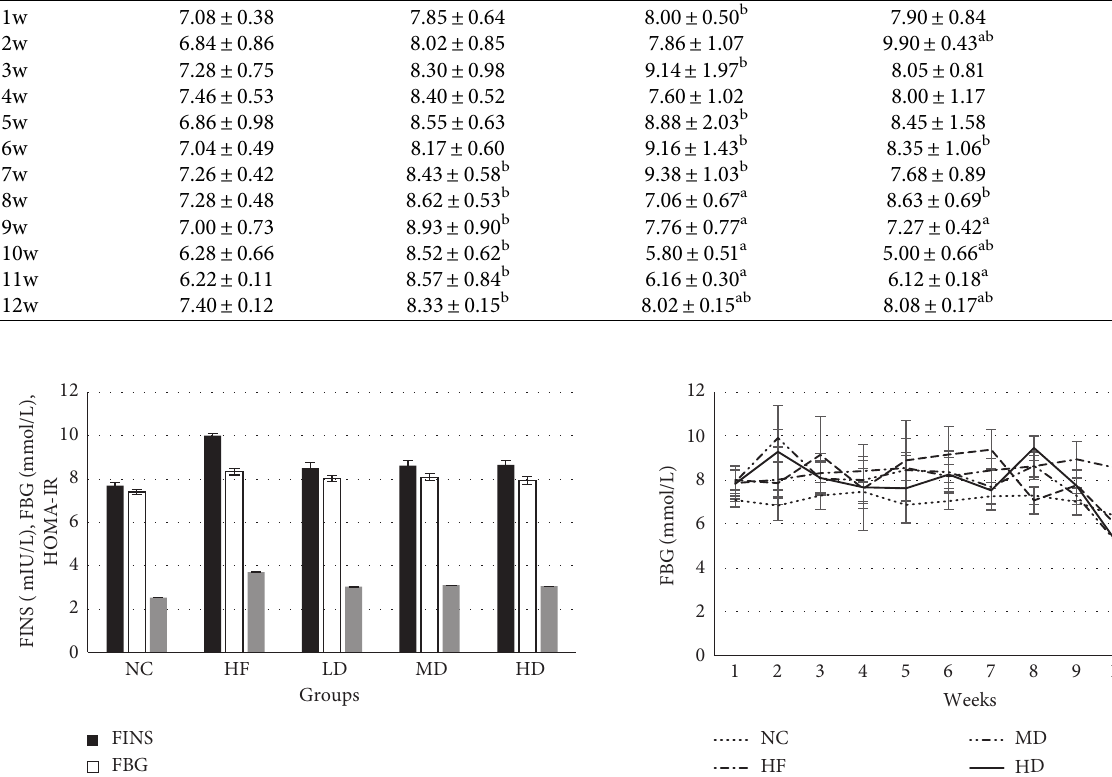
Table 3: Changes in FBG in each group for 12 weeks (means ± SD, mmol/L). a Compared with the HF group, the difference was statistically significant ( P < 0 . 05); b Compared with the NC group, the difference was statistically significant ( P < 0 . 05). Time